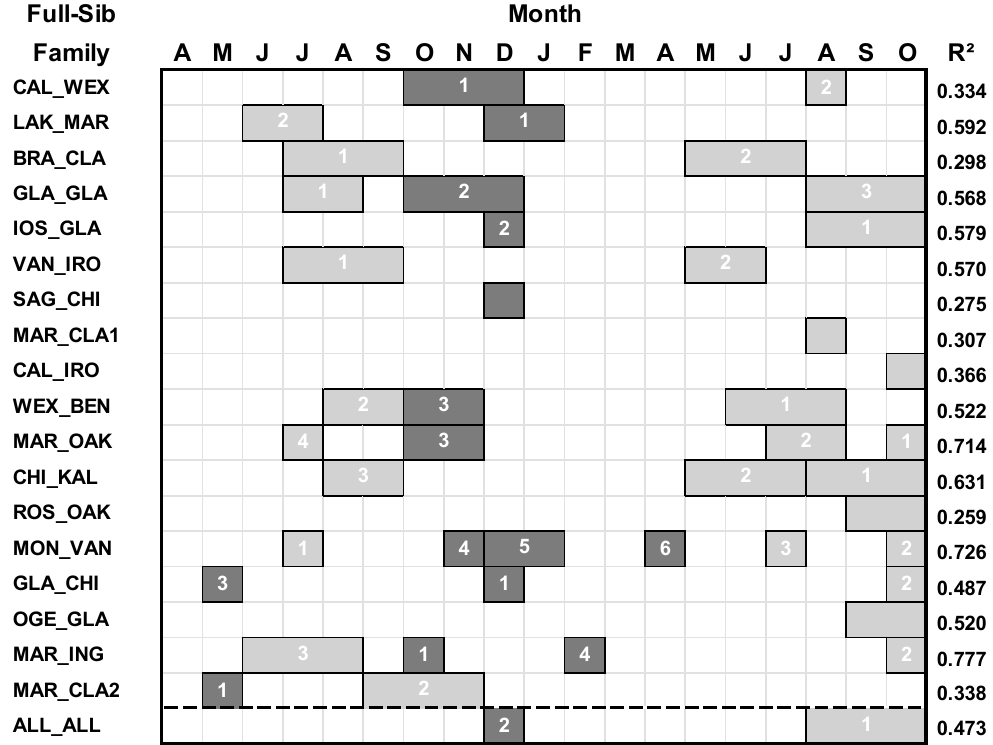
Figure 4. Regression models between basal area index (BAI) and moisture index variables for each family of hybrid aspen and all families combined. Climate variables spanned April of the prior year ( t-1 ) to October of the current year ( t ). For each regression model, predictor climate variables having a positive relationship with growth are denoted by light gray boxes, and predictor climate variables having a negative relationship with growth are denoted by darker gray. The numbers within the boxes denote the ranking of the climate variables according to their standardized regression ( β ) coefficient (highest = rank 1).